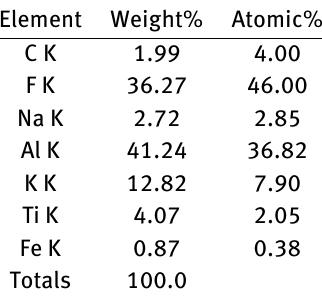
Figure 10: EDS spectrum and micro-area components of the